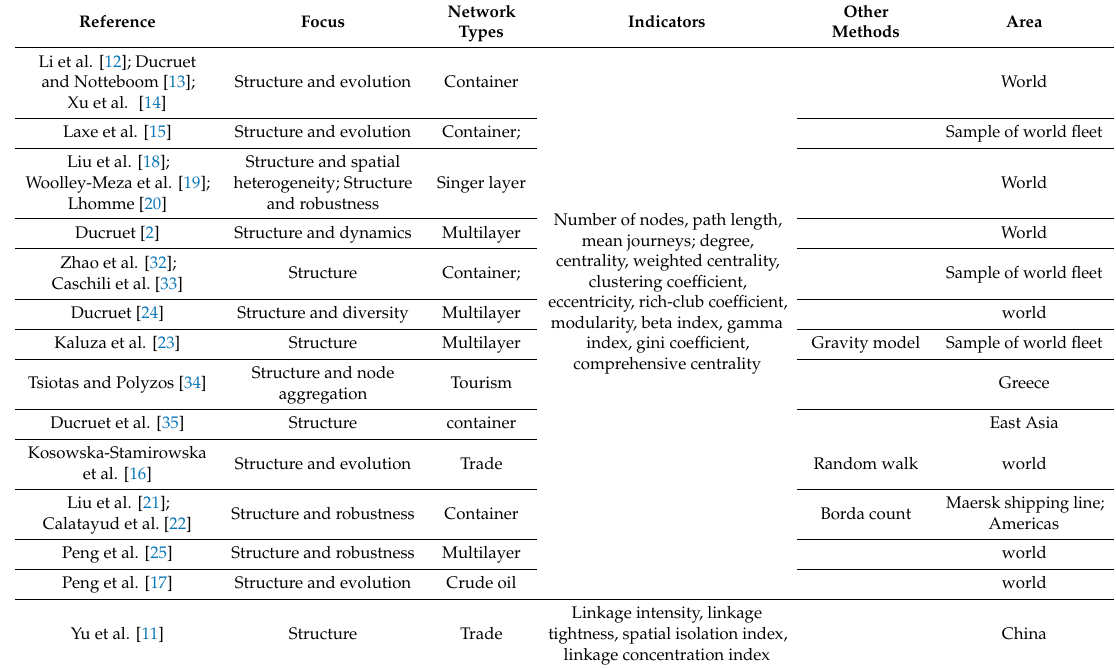
Table 1. Summary of research on maritime network